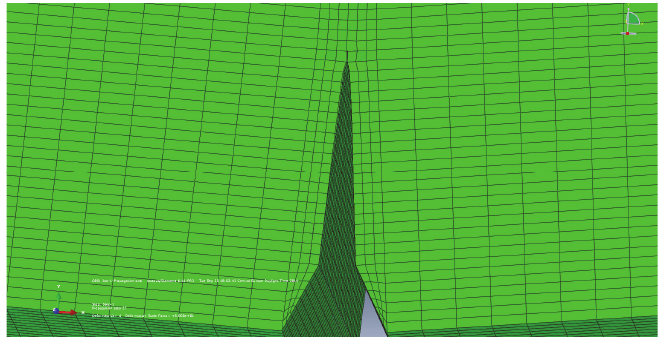
Figure 4: Crack length after 27 th